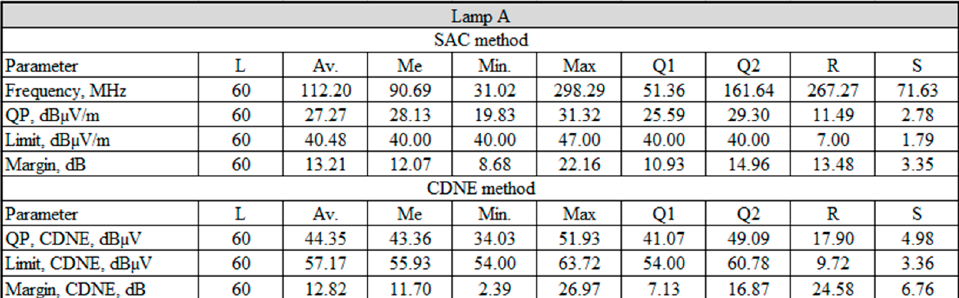
Figure 8. Recorded QP values using the new and traditional method against the allowable limits for LED lamp A under test, where: L—number of analysed values; AV—calculated average value; Min, Max—minimum and maximum values; Q1, Me(Q2), Q3—first, second and third quartile; R—range; and S—standard deviation.